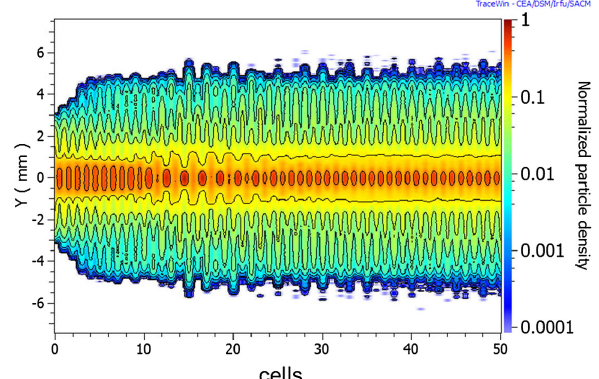
FIG. 7. Density in y with contour plots for k 0 ;x;y ¼ 120 °, k x;y ¼ 73 ° for waterbag distribution beam.